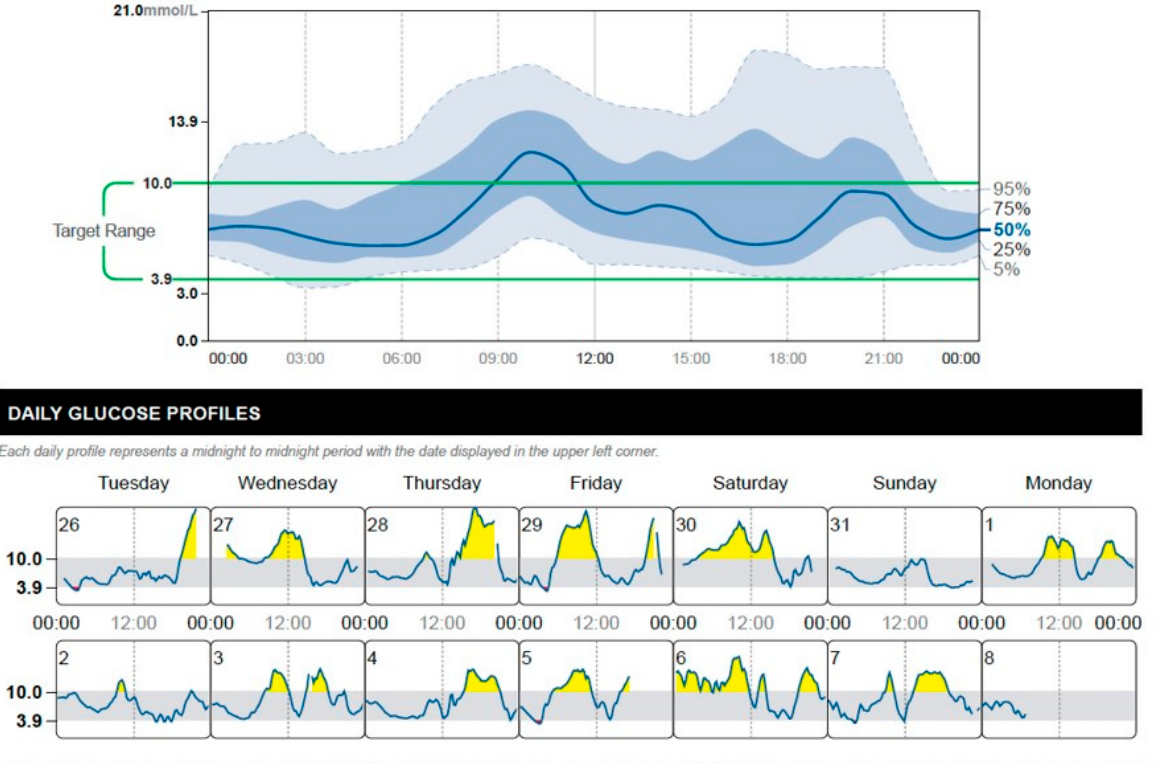
Figure 1. Ambulatory glucose profile CGM-based glycemic targets are personalized. Stringent targets should be set for young patients while looser targets are recommended in older/frail patients and those with multiple comorbidities and a high hypoglycemic risk (Table 2). Although dedicated studies regarding optimal TIR for diabetic patients on dialysis are lacking, TIR cut-offs should be loosened as recommended for frail patients to decrease the risk of hypoglyce- mia. 7. What Have Studies Shown with CGM in the Setting of Chronic Hemodialysis?